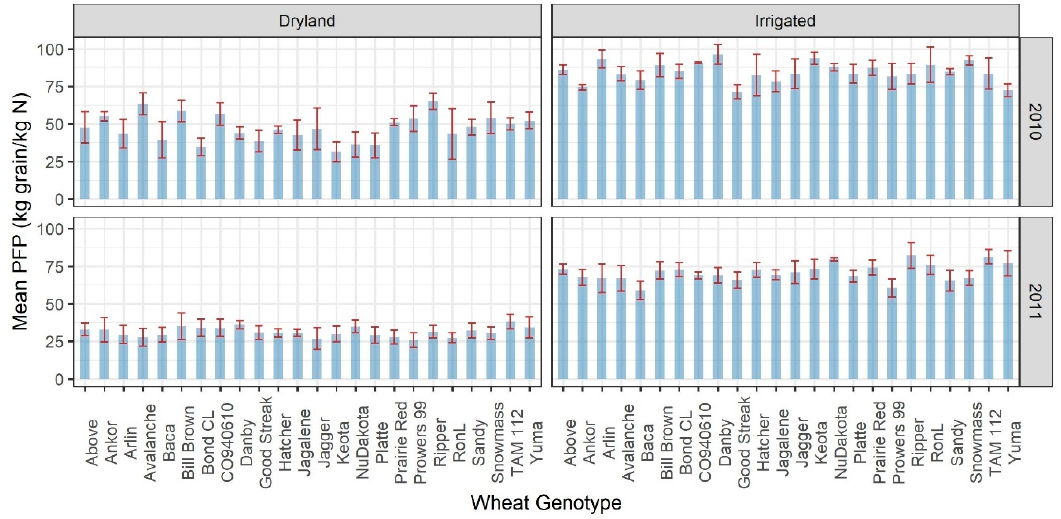
Figure 2. Mean nitrogen use efficiency as the partial factor productivity (PFP) across 24 winter wheat genotypes for ( top - left ) dryland in 2010, ( top - right ) irrigated conditions in 2010, ( bottom - left ) dryland in 2011, and ( bottom - right ) irrigated land in 2011. Error bars are the standard errors.